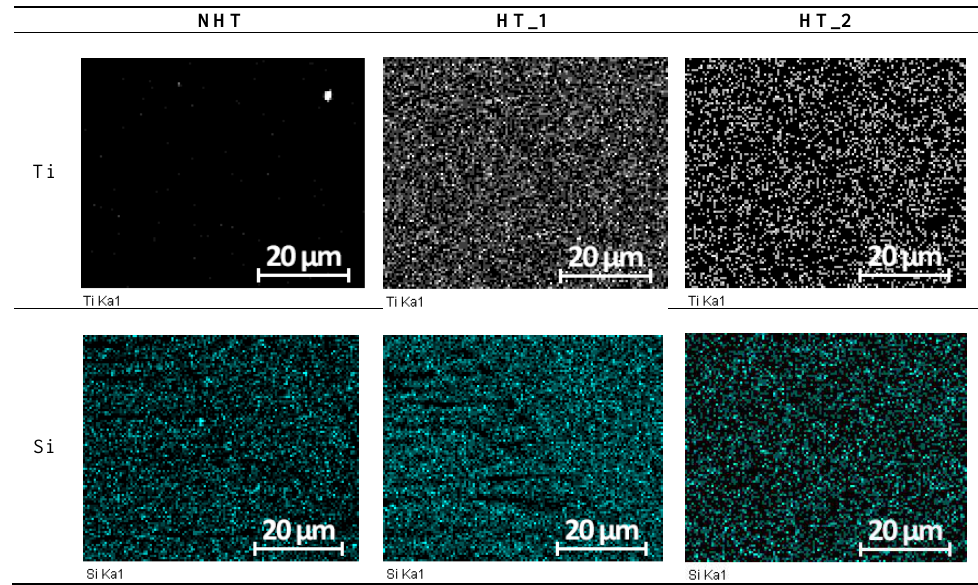
Figure 6. Electron dispersive spectroscopy (EDS) of the titanium and silicon.